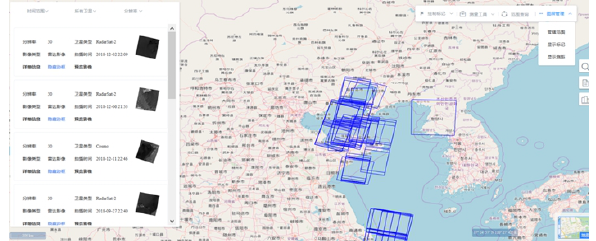
Figure 4.Platform data